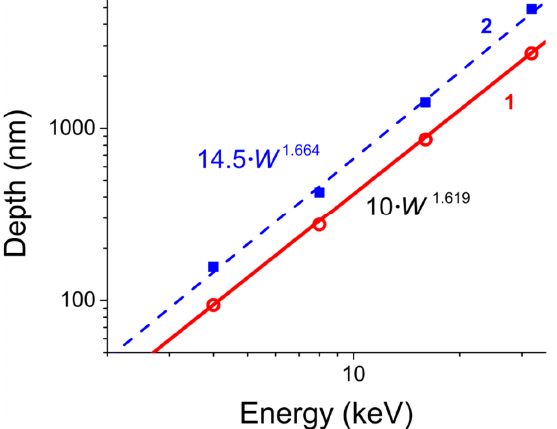
Figure 6. Based on CASINO modeling, calculated energy dependences (points) and their approxi- mation (lines) of mean electron penetration depth for BF16 (1) and Menzel (2) glasses. The non-uniform charge distribution in e-beam-poled glasses (see Figure 5) results in a non-uniform distribution of the electric field. The magnitude and distribution of the electric field E determines the second-harmonic (SH) wave intensity generated in the glass by the “frozen” electric charge. This requires electrostatic modeling of the problem to com- pare SHG efficiency in glasses irradiated with electrons of different energies. We per- formed such modeling assuming that the nonlinear interaction is weak, and the nonlinear interaction length d (the length of interaction of the laser beam with the region of nonlin- earity) does not exceed a half of so-called SHG coherence length (cid:1838) (cid:3030) = (cid:3090) , where (cid:2872)((cid:3041) (cid:3118)(cid:3352) (cid:2879) (cid:3041) (cid:3352) ) n 2ω and n ω are indices of the nonlinear medium for harmonic and fundamental radiation, respectively [32]. This assumption is valid for glasses under study because, for these sam- ples, L c lay in the range of tens of microns due to their relatively low dispersion, while an estimated value for d falls in the range of several microns. We used the results of the mod- eling (details are in Supplementary Material) for electron energies 4, 8, 16, and 32 keV to estimate the character of the SHG signal dependence on the electron beam energy using the approach proposed in [33]. The results of the modeled dependence of SHG intensity for BF16 glass on electron beam energy are presented in Figure 7.